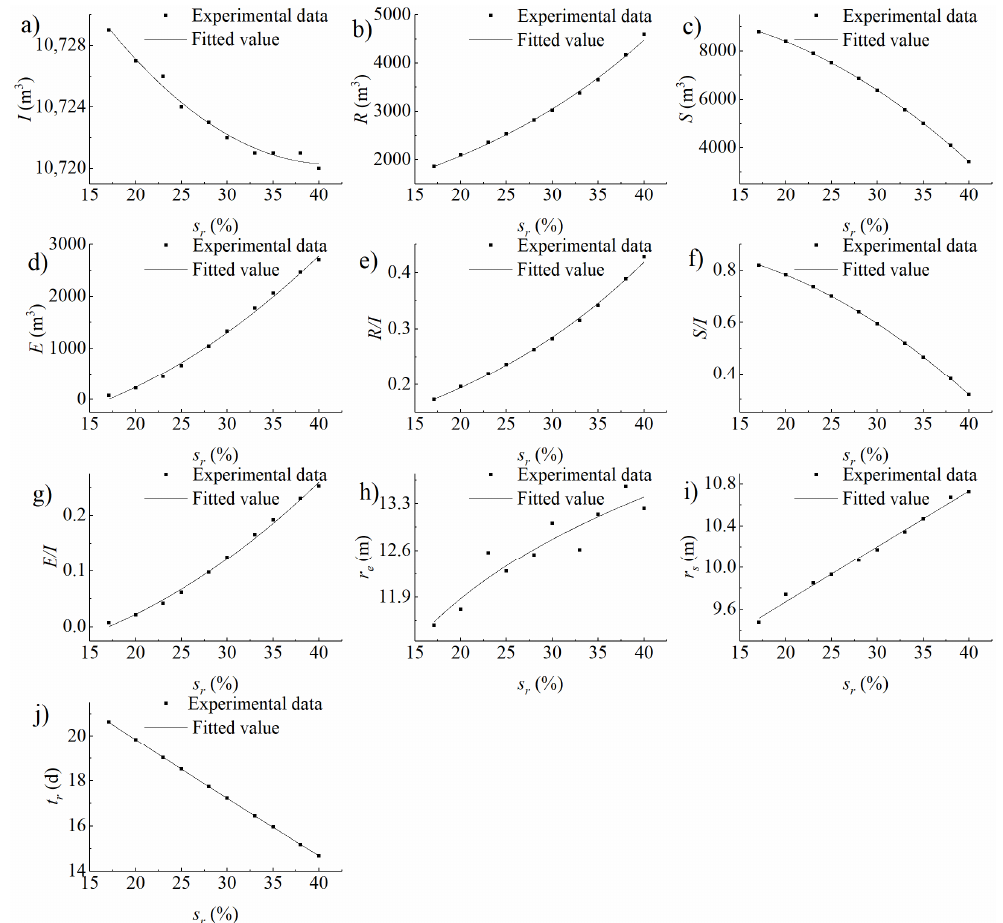
Figure 4. The variations with an increment in e. (( a ) variation of I; ( b ) variation of E; ( c ) variation of E/I.).